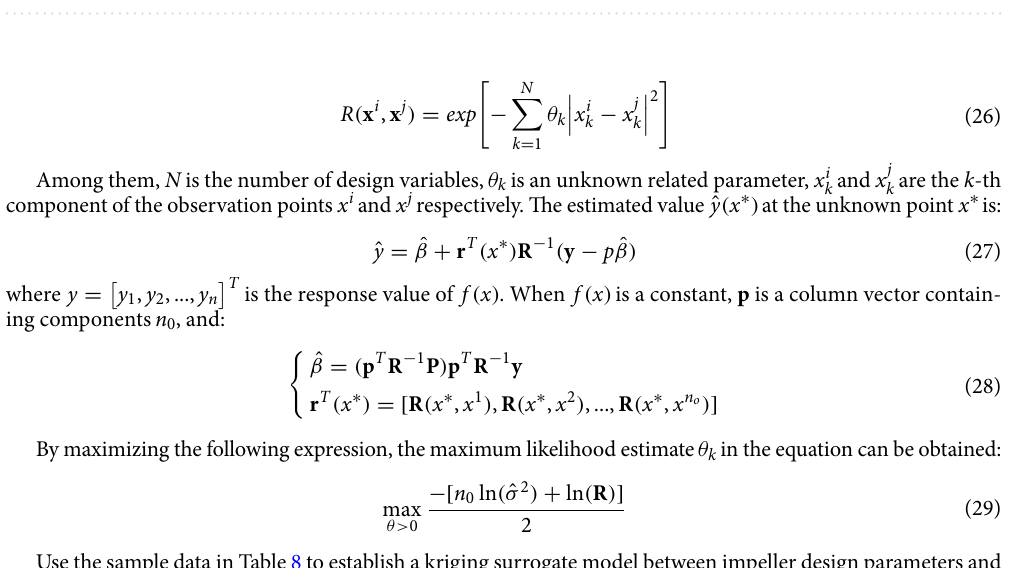
Table 9. Kriging model prediction value and original design